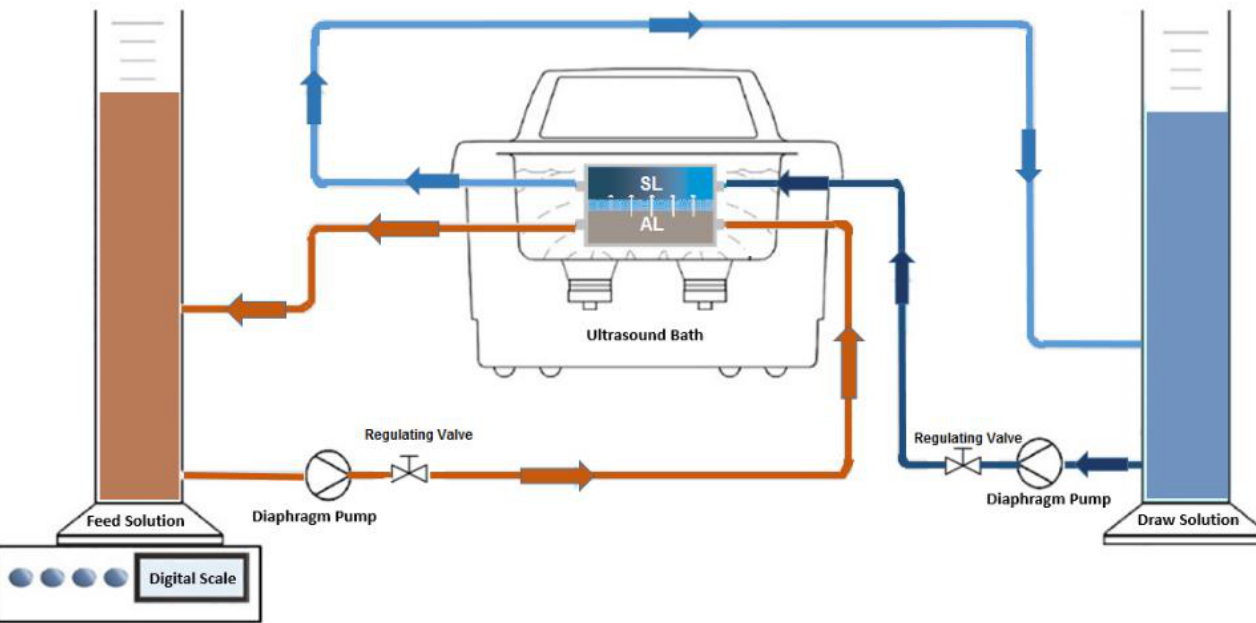
Figure 1. Experimental setup arrangement in ultrasound-assisted FO process with co-current flow and the active layer facing the ultrasound transducer.